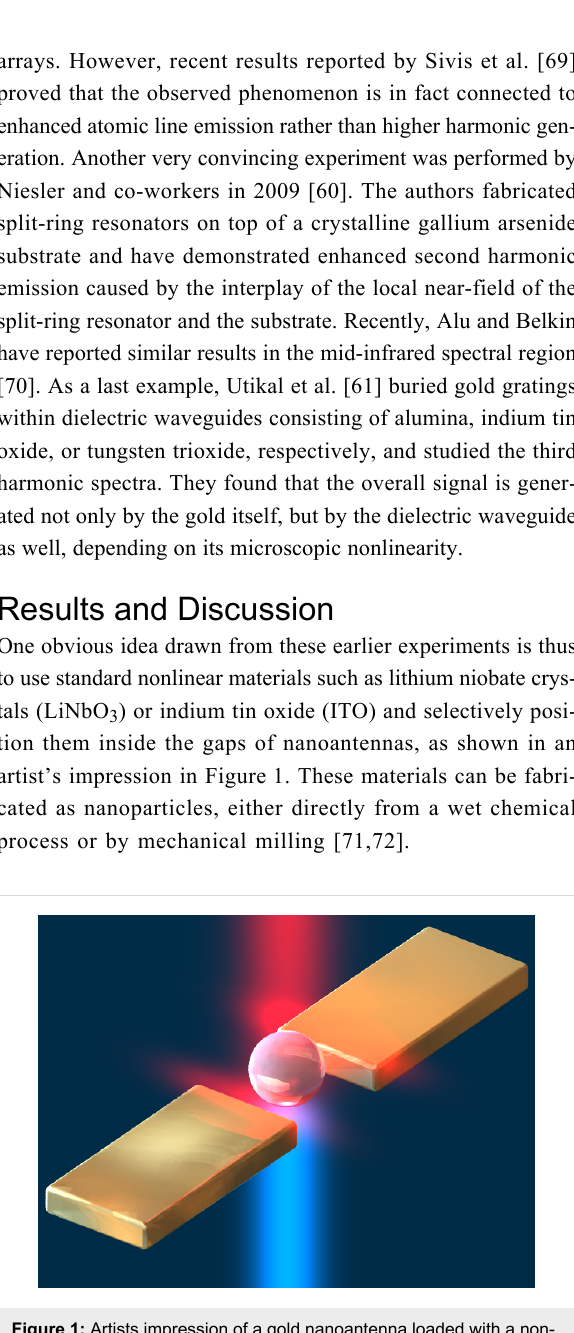
Figure 1: Artists impression of a gold nanoantenna loaded with a non- linear optical active material. The nanoantenna confines the incoming radiation, enhancing its field strength significantly in the process. The local fields then drive the conversion process in the nonlinear material. If the material intrinsically breaks inversion symmetry, it can produce even numbered harmonics. These even orders cannot be generated by the antenna itself, due to its centrosymmetry, at least as long as one only considers the electric dipole approximation. Reproduced with permission from [65], Copyright (2014) American Chemical